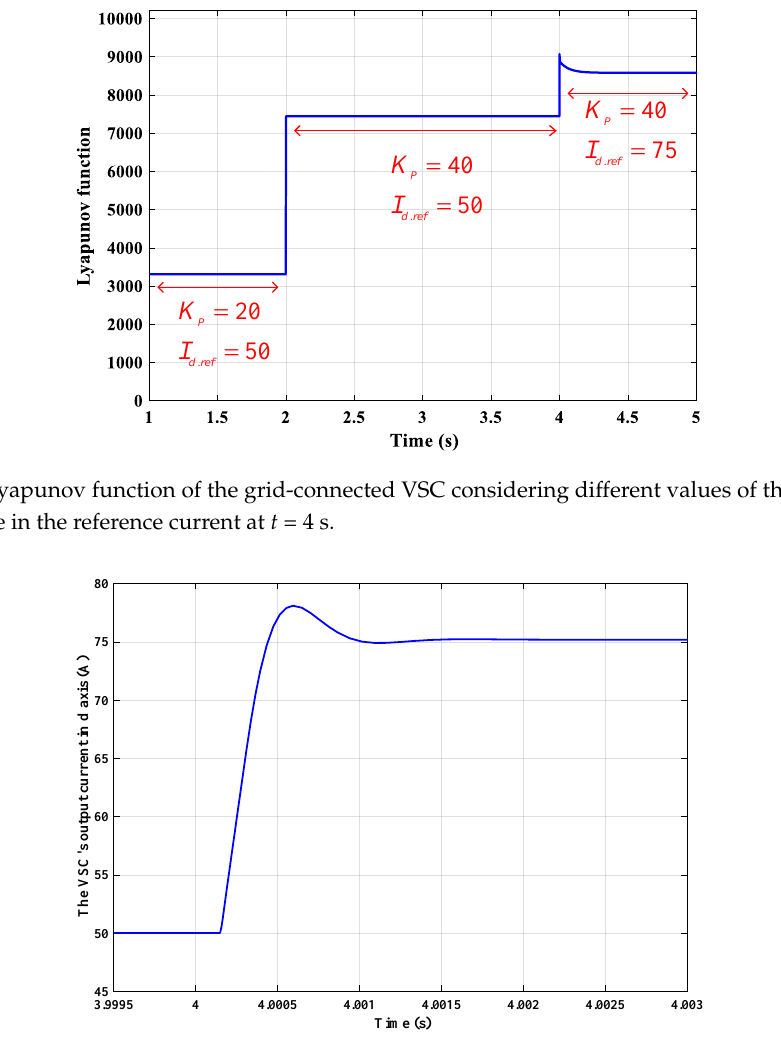
Figure 9. The VSC’s output current response to the step change in current reference from 50 A to 75 A at t = 4 s with K P = 40.